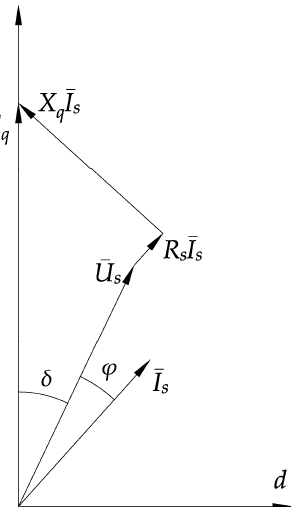
Figure 1. Voltage-current phasor diagram of a synchronous generator.